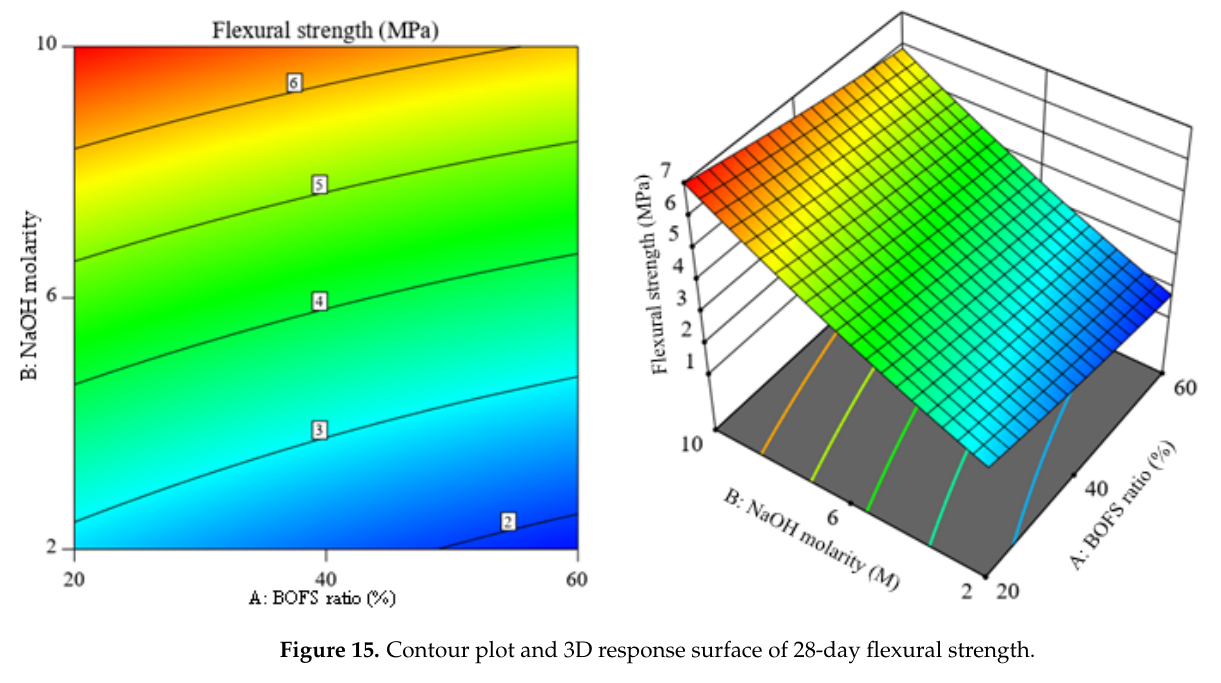
Figure 15. Contour plot and 3D response surface of 28-day flexural strength.